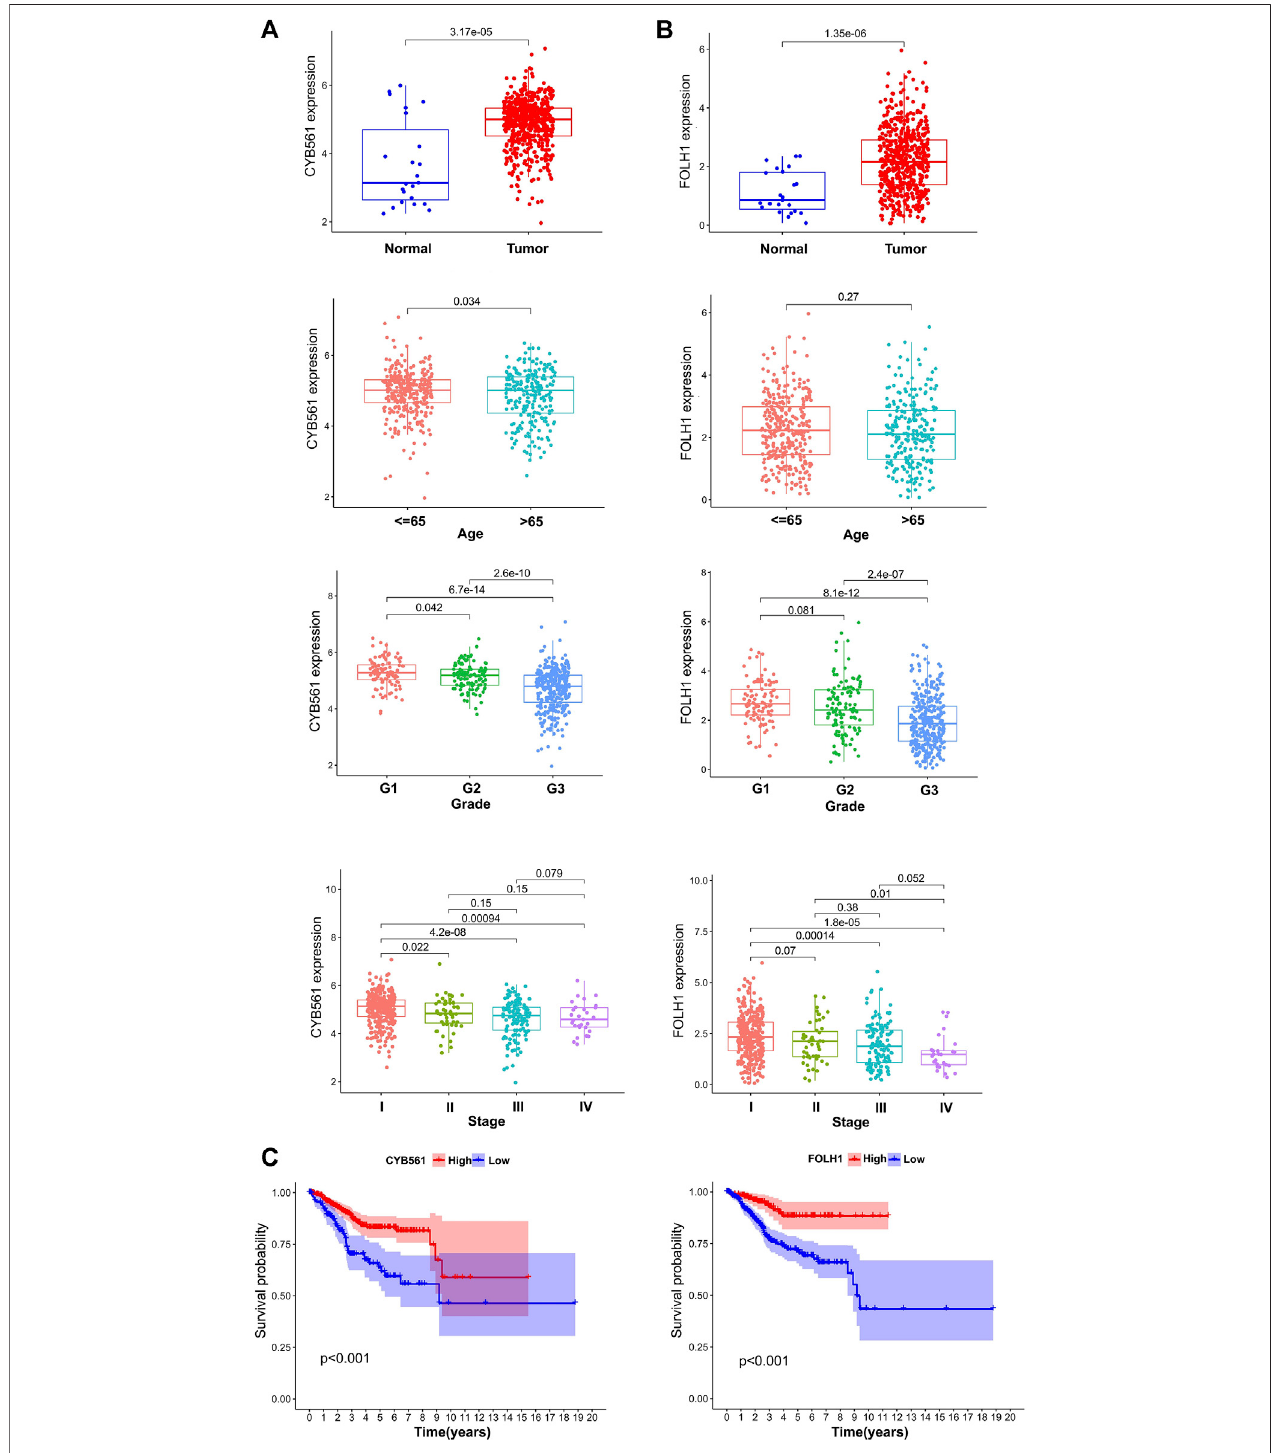
FIGURE 6 | The prognostic signature of CYB561 and FOLH1 expression. The expression of CYB561 (A) and FOLH1 (B) in age, grade, and stage groups. (C) Kaplan-MeiersurvivalcurveofCYB561andFOLH1inhigh-andlow-expressiongroups.Thebottomandtopoftheboxesarethe25thand75thpercentiles(interquartile